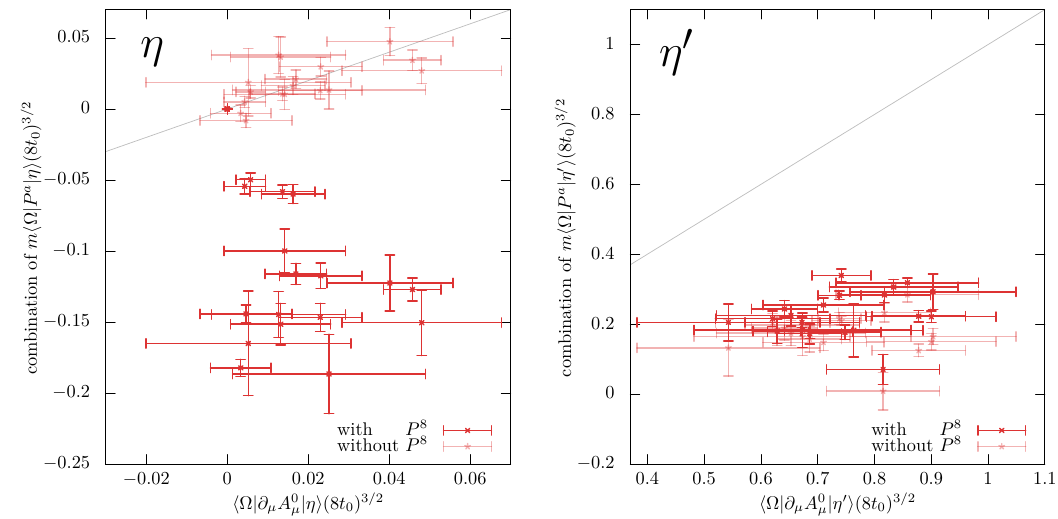
Figure 7. Fermionic contributions to the singlet AWI for the η and η 0 states. Light points correspond to only the singlet contribution whereas the darker points correspond to all pseudoscalar terms in eq. (6.4), but the anomalous contribution is